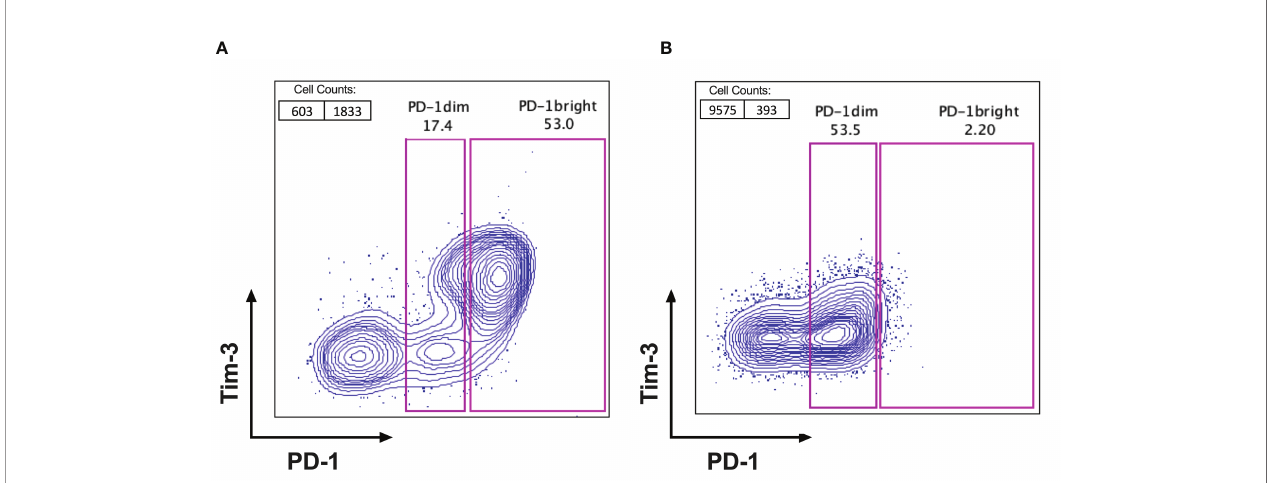
FIGURE 1 | Identi fi cation of PD-1 high expressers and PD-1 low expressers. FACS plots with PD-1 (X axis) VS Tim-3 (Y axis) were gated on CD3+ and CD8+ TILs after excluding the dead cells from fresh surgical or biopsy tumour samples of cervical cancer patients. Based on the fl uorescent intensity of PD-1 on CD8+TILs, patients can be cellularly sub grouped as (A) PD-1 high expressers; with 2 distinct PD-1 populations observed on FACS dot plots (PD-1 dim and PD-1 bright ) and the percentage of PD-1 bright subpopulation is higher than that of PD-1 dim subpopulation and (B) PD-1 low expressers; with only one PD-1 positive population visible on FACS dot plots and the percentage of PD-1 bright is lower than that of PD-1 dim